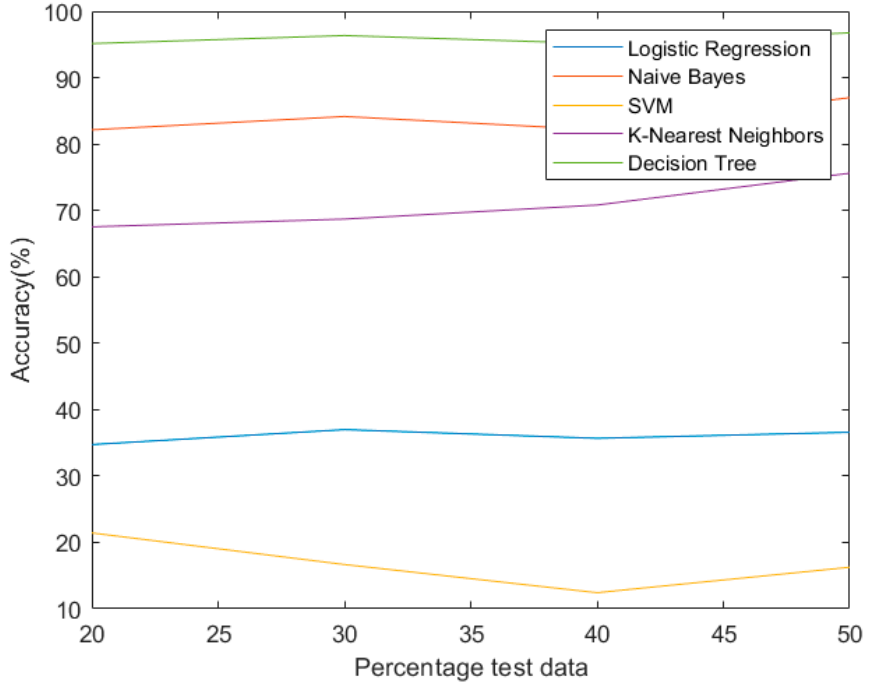
Figure 9. Percentage accuracy vs. percentage test data.